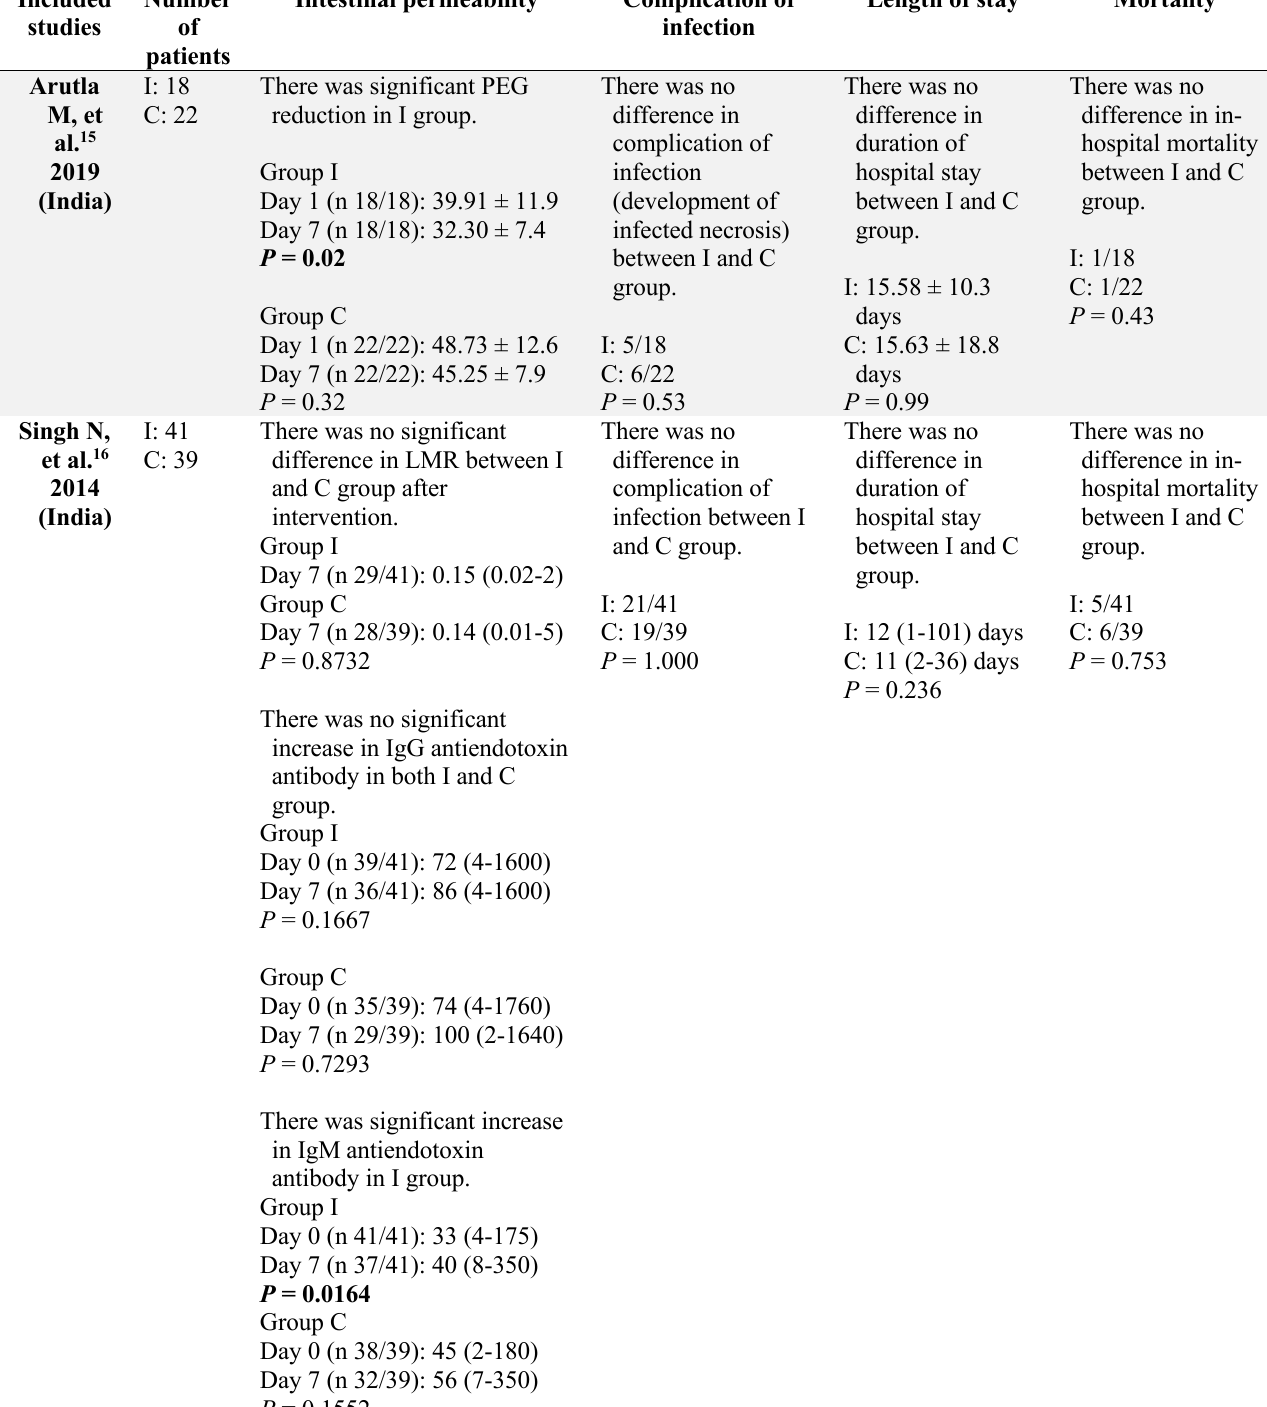
Table 4 . Summary of clinical outcomes of included studies